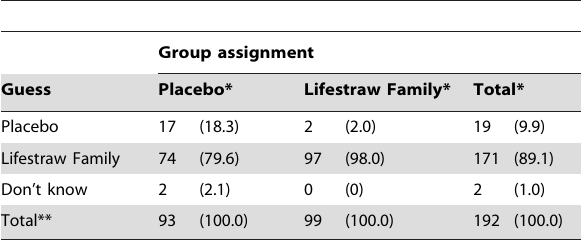
Table 5. Blinding status of respondents by group assignment at the end of the